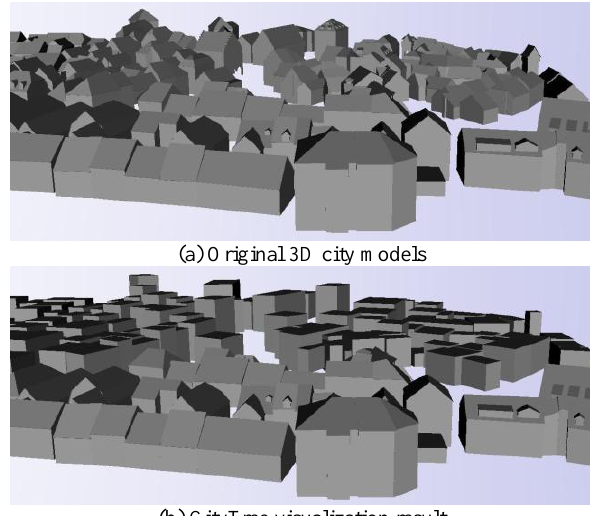
Figure 3. City Model visualization